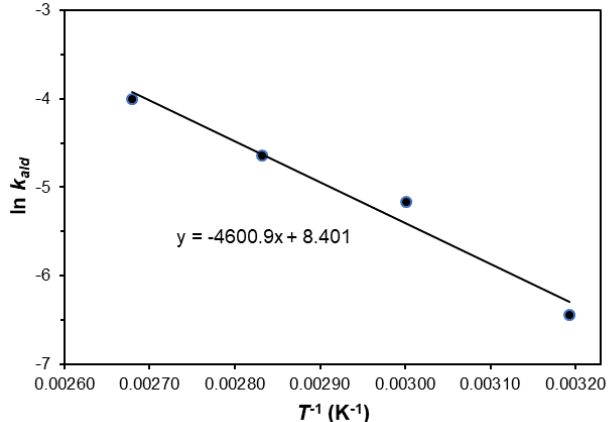
Figure 8. Arrhenius plot for aerobic oxidation of PhCHO (4.9 mmol) catalyzed by HPA-1 (0.10 g, 0.048 mmol) in the presence of DBT (0.50 mmol); 10 mL dodecane, 20 mL min − 1 air flow and 1300 rpm stirring speed; k ald is the first-order rate constant (min − 1 ); E a = 38 kJ mol − 1 .